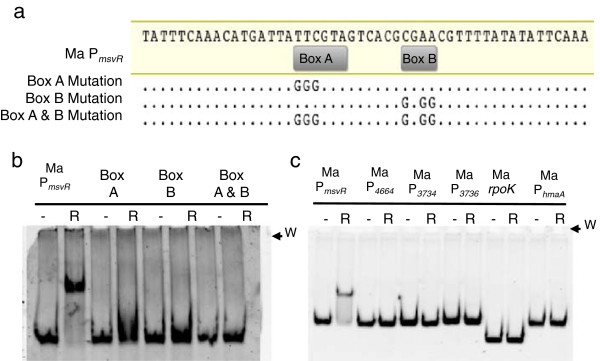
MsvR binding and regulatory targets assessed by EMSA. (a) Sequences of the 50 bp region of Ma PmsvR used to confirm MaMsvR binding to boxes A and B. Sequence changes within the binding boxes are shown. (b) EMSA assays with the template (50 nM) variations shown in (a) and 1 μM (20-fold excess over DNA) reduced MaMsvR (R, 5 mM DTT). A 50 bp region of Ma PmsvR was included as a binding control. The gel wells are indicated (W). (c) EMSA analysis with reduced MaMsvR (R, 5 mM DTT) and its own promoter (Ma PmsvR, 10 nM), various intergenic regions of an oxidative stress response cluster (Ma P4664, P3734, P3736, 10 nM) as well as the control Ma histone A promoter (Ma PhmaA, 10 nM). A region of rpoK (10 nM) was tested for binding because an MsvR binding site (TTCGN8CGAA) is present in the coding region. The gel wells are indicated (W).